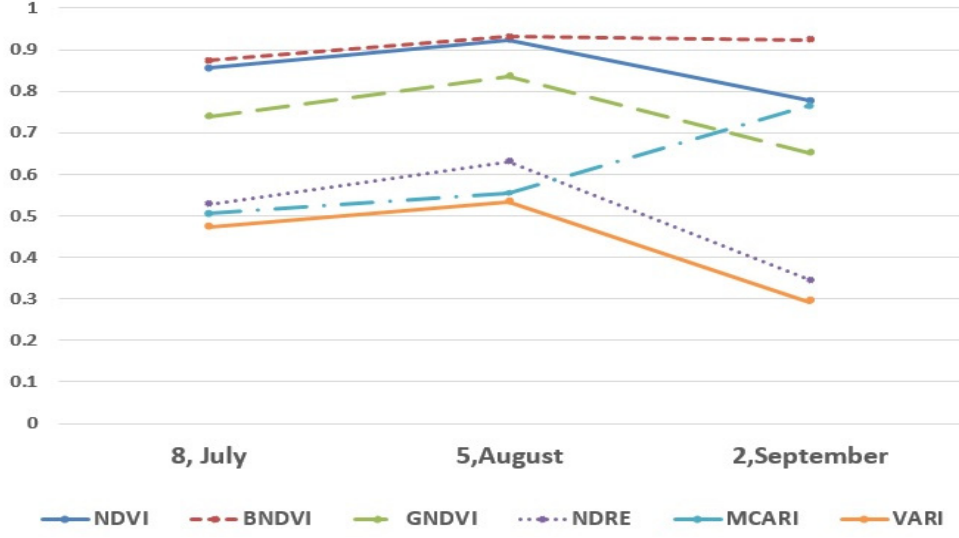
Figure 9. Temporal changes of each index value of rice paddy. (Micasense images).